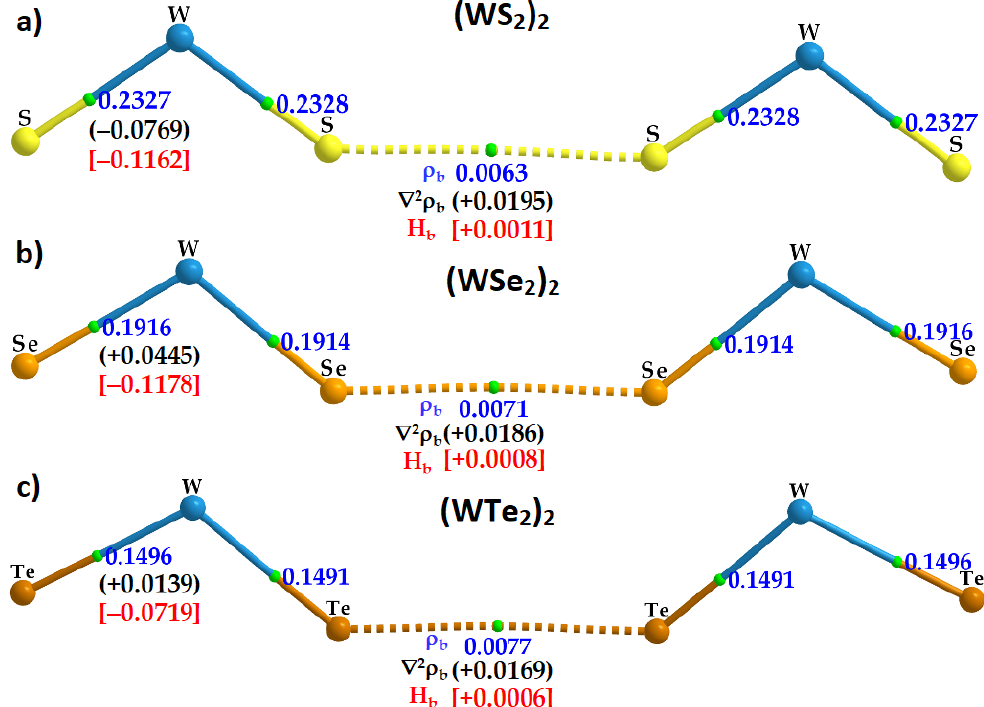
Figure 8. M06-2X/Aug-cc-pVTZ(-PP) computed QTAIM-based molecular graphs, presenting a description of intra- and inter-molecular interactions in WCH 2 dimers: ( a ) (WS 2 ) 2 ; ( b ) (WSe 2 ) 2 ; and ( c ) (WTe 2 ) 2 . Shown are the charge density ( ρ b /a.u.; numbers in blue), the Laplacian of the charge density ( ∇ 2 ρ b /a.u.; numbers in black), and the total energy density ( H b /a.u.; numbers in red) at the Ch···Ch bond critical points. The former property is also depicted at the W–Ch bond critical points. Bond paths and bond critical points are shown as lines in atom color and tiny spheres in green between bonded atomic basins, respectively. Large spheres represent atomic domains for each dimer.